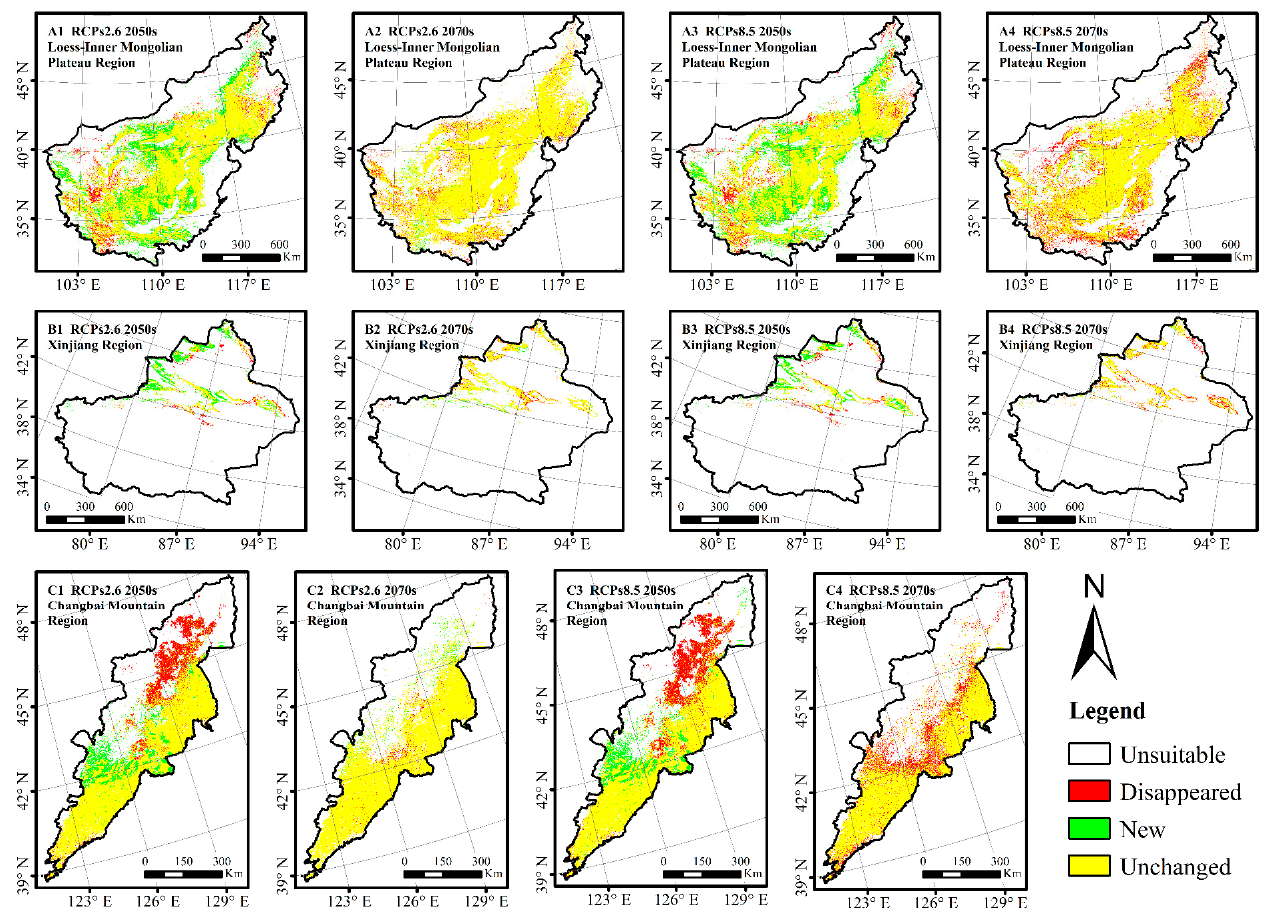
Figure 3. The potential distribution range shift in the extent of Juniperus rigida Sieb. et Zucc. under the low concentration emissions pathway (RCP2.6) in three regions. The changes in the 2050s to current showed in ( A1 ), ( B1 ), and ( C1 ) under RCP2.6, and in ( A3 ), ( B3 ), and ( C3 ) under RCP 8.5. ( A2 ), ( B2 ), and ( C2 ) illustrated the changes in 2070s relative to 2050s under RCP 2.6, ( A4 ), ( B4 ), and ( C4 ) for RCP 8.5.